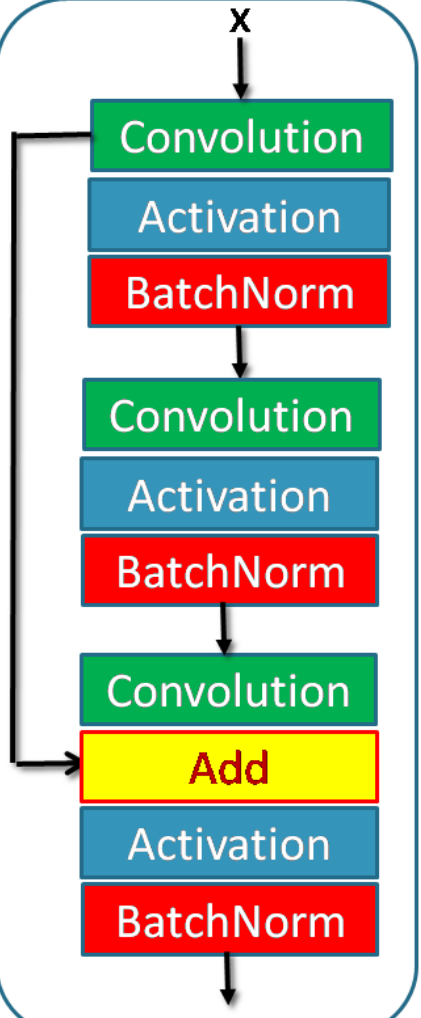
Figure 5. Residual convolution block. The stack of convolution operators and the sequence of Batch–Norm and activation layers are customized.